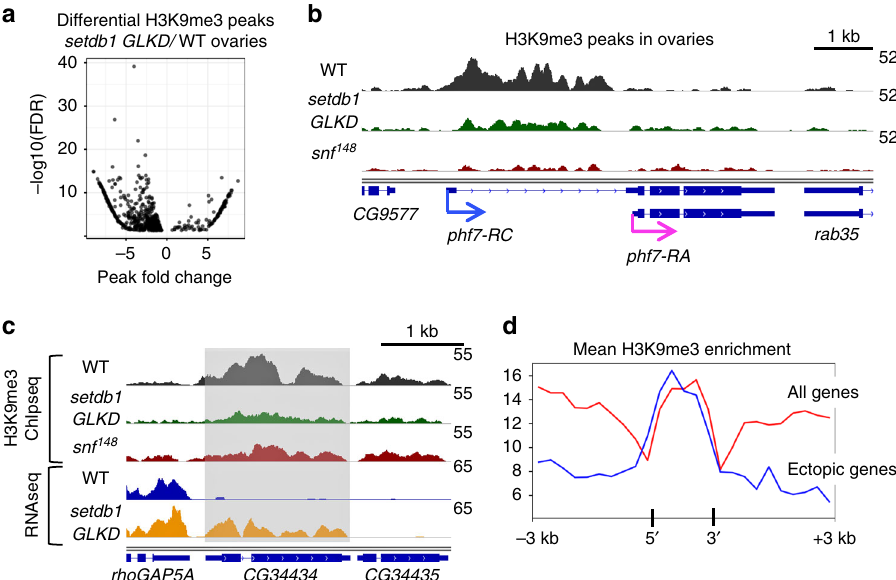
Fig. 4 Loss of SETDB1 in female germ cells leads to H3K9me3 depletion on a select set of genes a Differential analysis of paired H3K9me3 ChIP-seq data sets identi fi es SETDB1-dependent H3K9me3 peaks. Scatter plot showing the signi fi cantly altered (FDR < 0.05) H3K9me3 peaks in setdb1 GLKD ovaries relative to wild-type (WT) ovaries. The x-axis is the log 2 H3K9me3 enrichment of wild-type peaks subtracted from the log 2 H3K9me3 enrichment of setdb1 GLKD peaks. Negative values indicate a reduction in H3K9me3 in mutant ovaries. b The H3K9me3 peak over the testis-speci fi c phf7-RC TSS is decreased in setdb1 GLKD and snf 148 mutant ovaries. Genome browser view of phf7 and neighboring genes CG9577 and rab35 . c In setdb1 GLKD ovaries, ectopic expression of CG34434 is correlated with a decreased in H3K9me3 accumulation. H3K9me3 accumulation is also decreased in snf 148 mutant ovaries. Genome browser view of CG34434 and its neighbors, rhoGAP5A and CG34435 . RNA reads in wild-type (WT) and setdb1 GLKD are in blue and orange, respectively. The ChIP-seq reads are in black, green and red. CG34434 is shaded. d Average enrichment pro fi le indicates that the H3K9me3 peaks at the 21 SETDB1-regulated genes are localized over the gene body. The average H3K9me3 enrichment pro fi le on the average gene body (transcription start site to transcription end site) scaled to 1500 base pairs, ±3 kb. In red, the average enrichment pro fi le of euchromatic genes which display an H3K9me3 peak